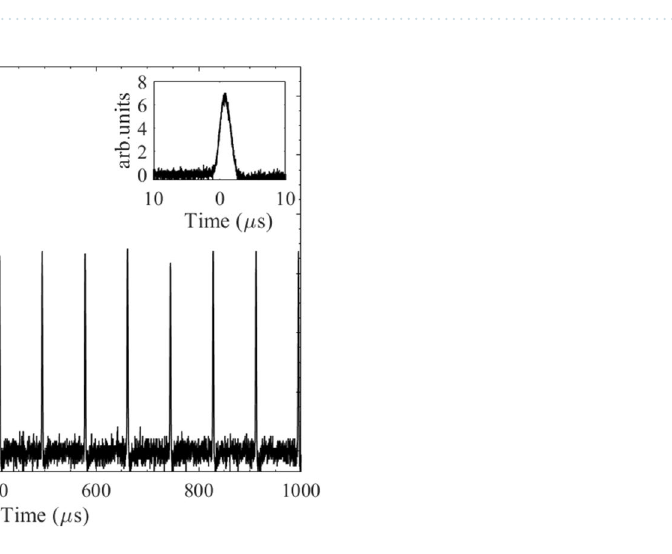
Figure 8. The average power of the laser versus the repetition rate for two different pump densities with R OC of 93%.